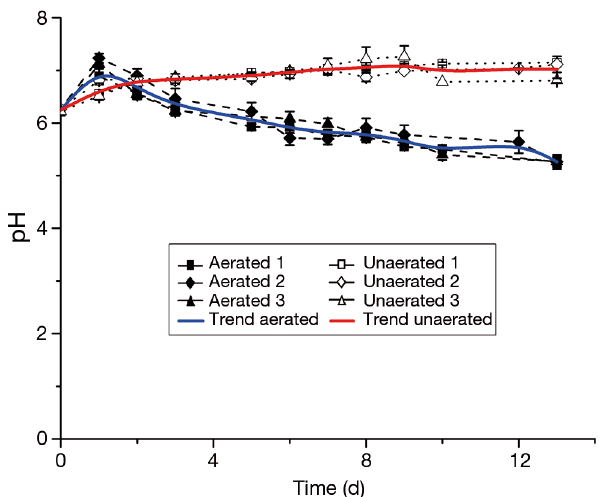
Fig. 4. pH in the liquid phase of a water-sludge mixture derived from a tilapia recirculating aquaculture system over 14 d (Day 0 to Day 13) of anaerobic (<0.1 mg O 2 l −1 , red) and aerobic (blue) mobilization. Data from 3 successive trials are presented as means ± SD. Trend line: mean of the successive trials (technical